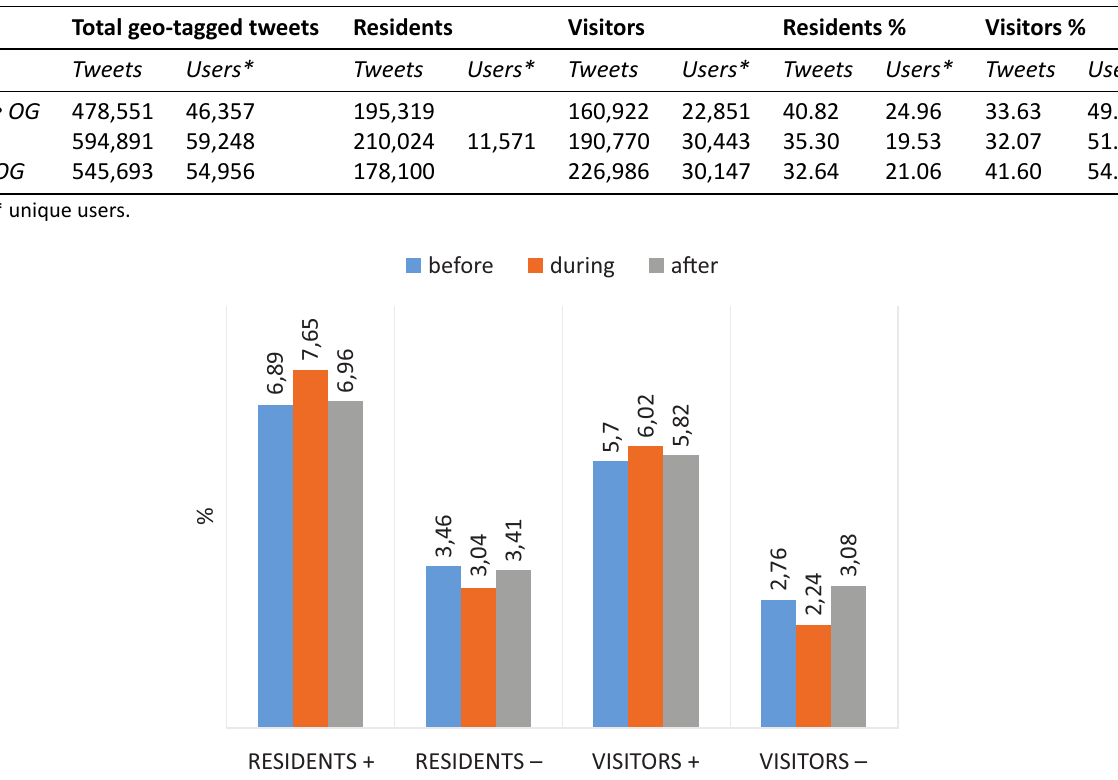
Figure 3. Sentiment analysis distribution for resident and visitors during the three temporal subsets